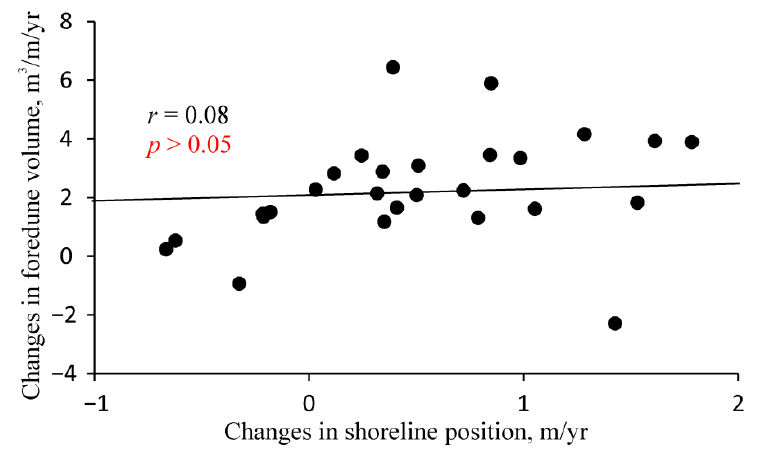
Figure 8. Correlation between changes in the shoreline position and foredune sand volume.